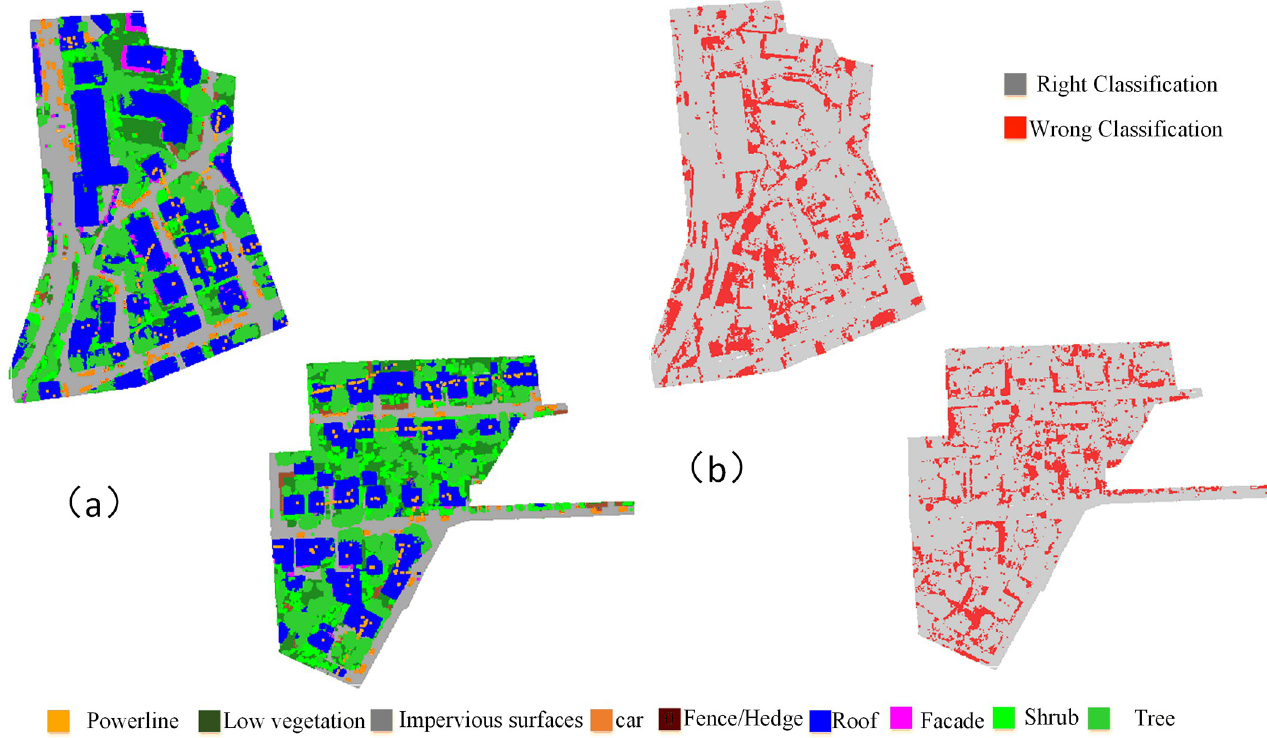
Fig 3. Prediction map (a) and error map (b) of our proposed method on the ISPRS benchmark dataset.